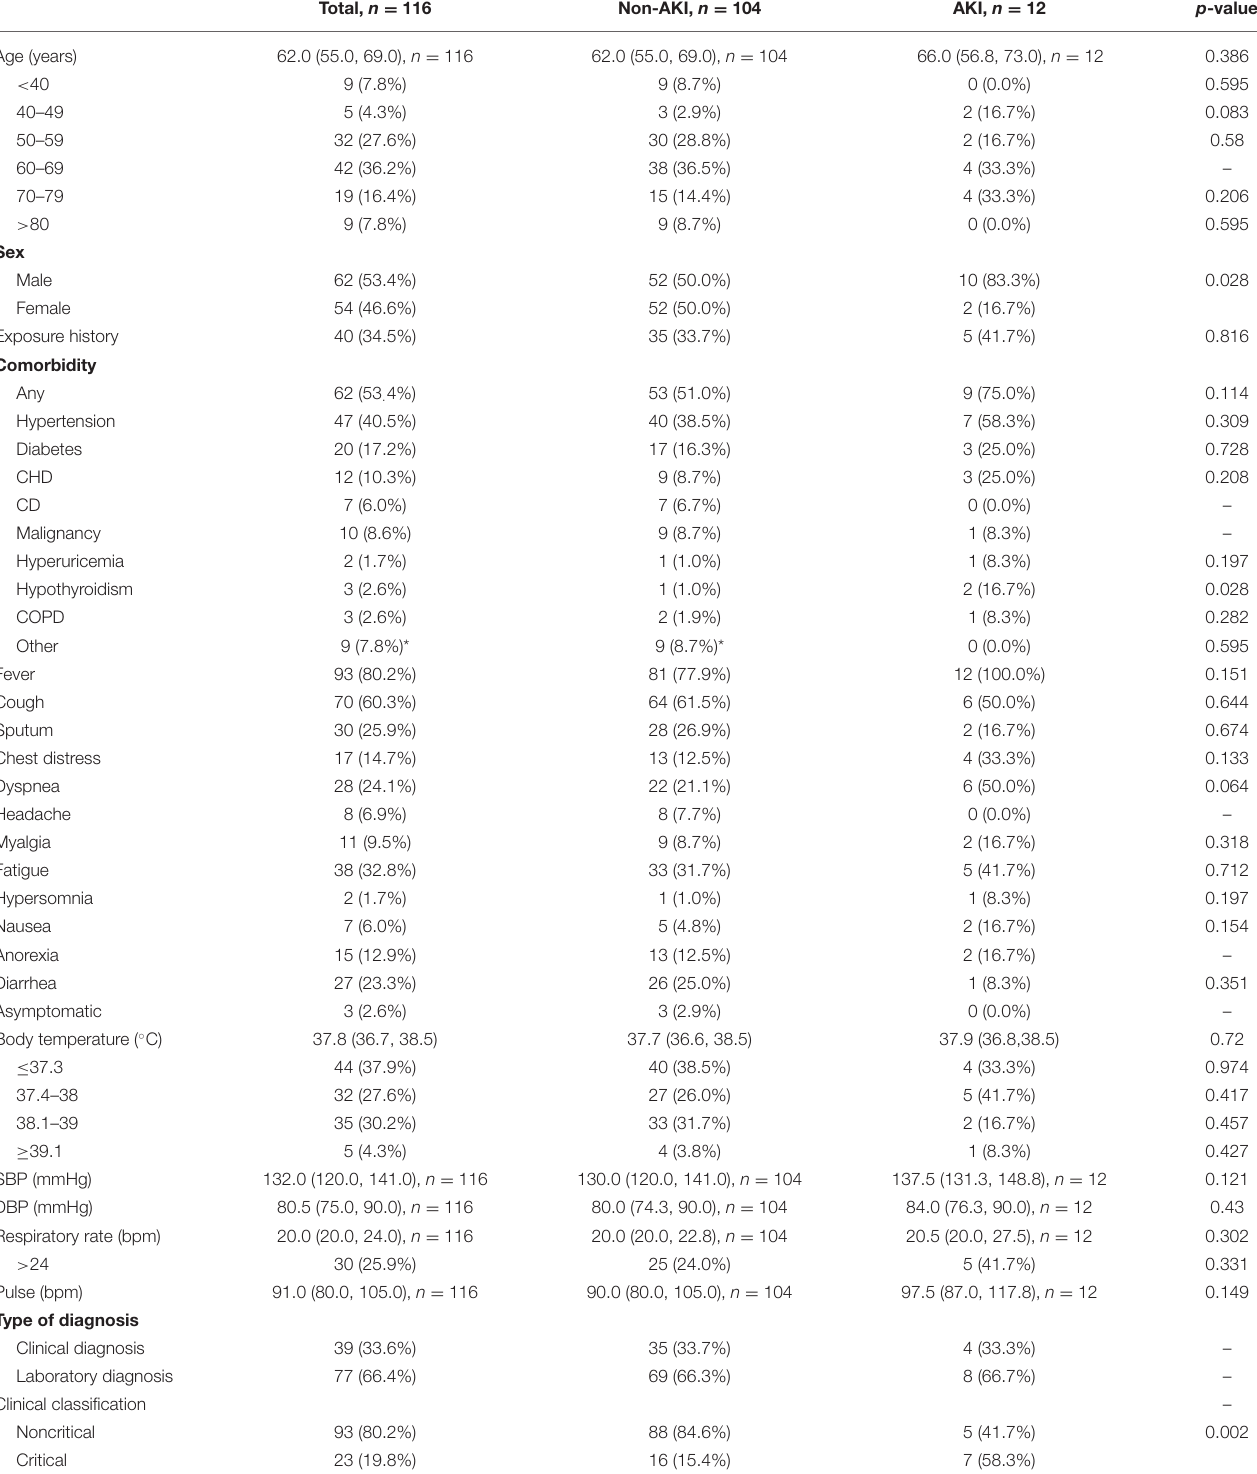
TABLE 1 | Demographic, epidemiological, and clinical characteristics of the